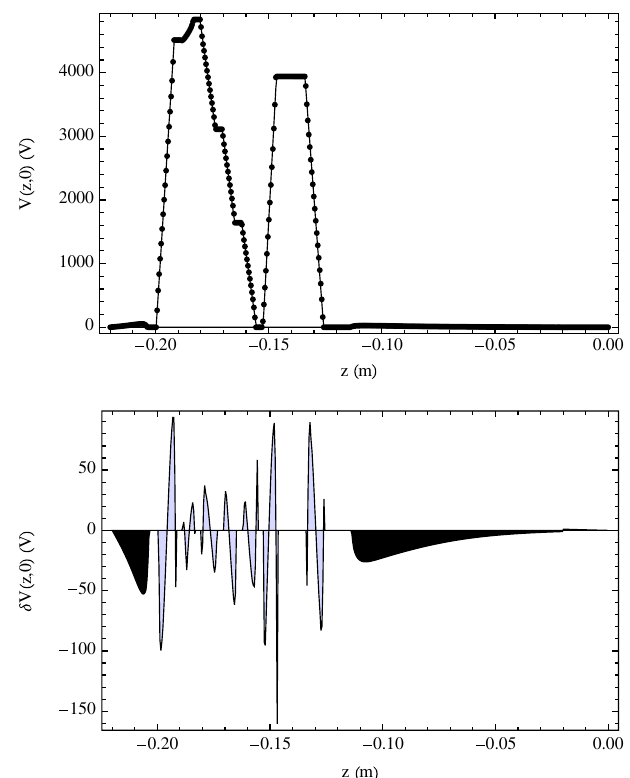
FIG. 7. The line represents the analytical function and the dots is the numerical solution (top). The difference between the two previous curves is shown in the bottom image. We see that the error is around 1% and its smooth repartition shows that it does not arise from the varying radius. This difference is the conse- quence of the approximation we used to fix V ð R; z Þ between the ¼ 4513 V , V ¼ 4836 V , V ¼ 3112 V , electrodes. Here ( V 1 2 3 ¼ 1642 V , V ¼ 3941 V ). V z 4